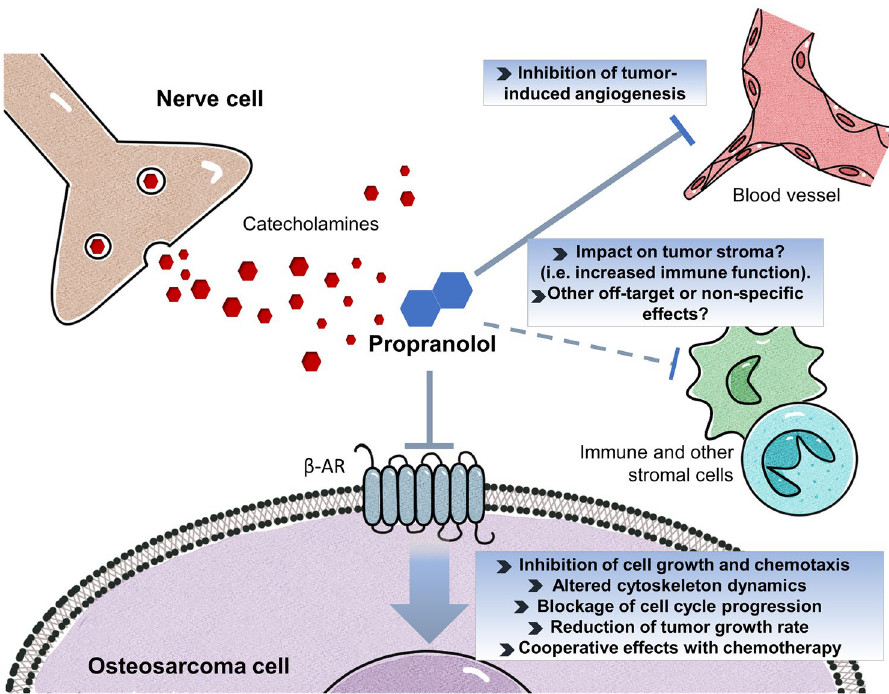
Figure 8. Potential antitumor activity and therapeutic benefits of repurposed β-blocker propranolol in osteosarcoma. β-AR signaling is involved in cancer progression and is upregulated in osteosarcoma (OSA). Its activation by catecholamines in tumor cells, as well as in other stromal players such as vascular and immune cells (i.e. neutrophils, macrophages, T cells, among others), promotes cell growth and angiogenesis, favors the formation of immune permissive niches and accelerates tumor progression. Besides antagonizing the growth- stimulating effects of catecholamines, treatment of ADRB2-expressing OSA cells with β-blocker propranolol (PPN) seems to inhibit cellular growth and chemotaxis by blocking cell cycle progression and altering actin cytoskeleton dynamics. PPN treatment could complement chemotherapy by inhibiting OSA-induced angiogenesis, enhancing tumor necrosis and thus delaying disease progression. With the aim of advancing PPN repurposing towards clinical practice further studies regarding its anti-OSA mechanisms of action are warranted, including its potential impact on tumor immune microenvironment and metastatic